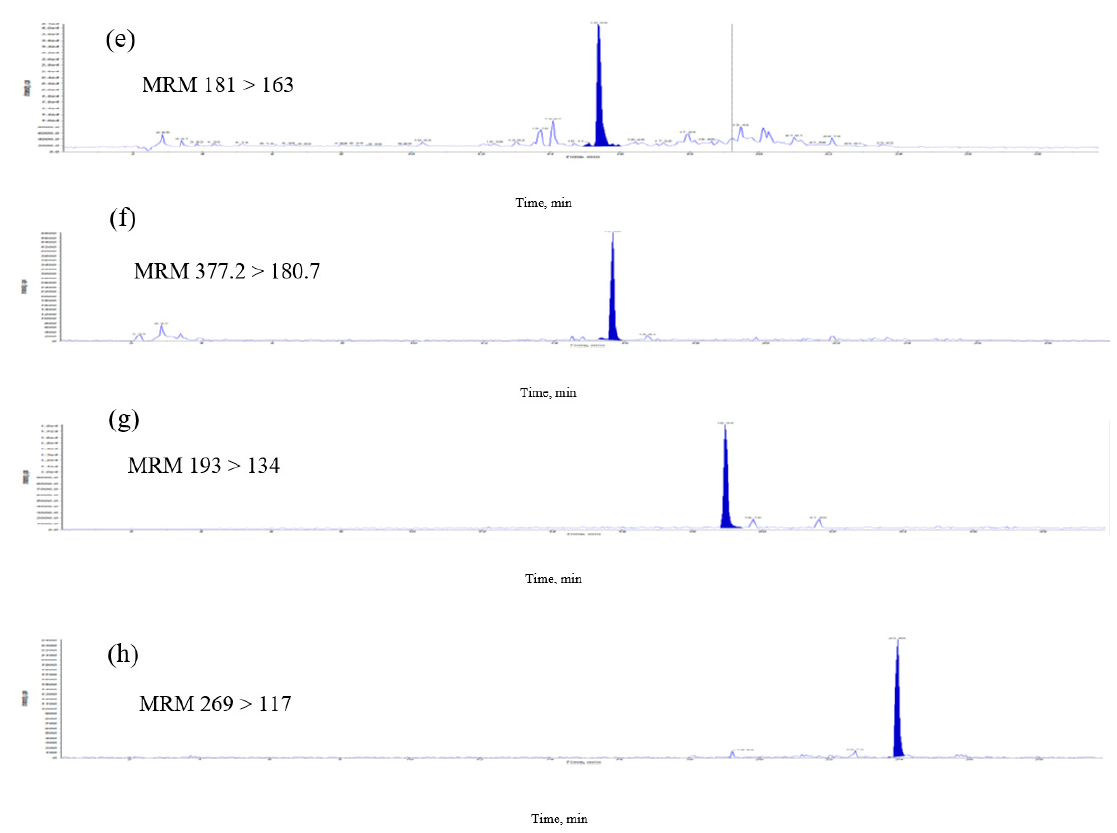
Figure 3. Multiple-reaction monitoring (MRM) chromatograms of extract of E. formosanus . ( a ) Thiamine, ( b ) pyridoxamin, ( c ) gallic acid, ( d ) chlorogenic acid, ( e ) caffeic acid, ( f ) riboflavin, ( g ) ferulic acid and ( h ) apigenin. Table 3. The contents ( μ g/g) of the eight signature compounds in the extract from E. formosanus ( n = 3). Thiami Gallic Chlorogenic Caffeic Sample Pyridoxamin Riboflavin ne acid acid acid